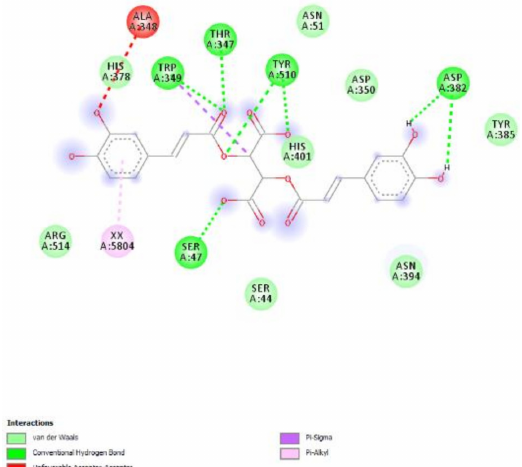
Figure 12. Putative interactions between chicoric acid and ACE2 (PDB: 1R4L). Free energy of binding ( ∆ G) and affinity (Ki) are − 7.5 kcal/mol and 3.2 µ M,